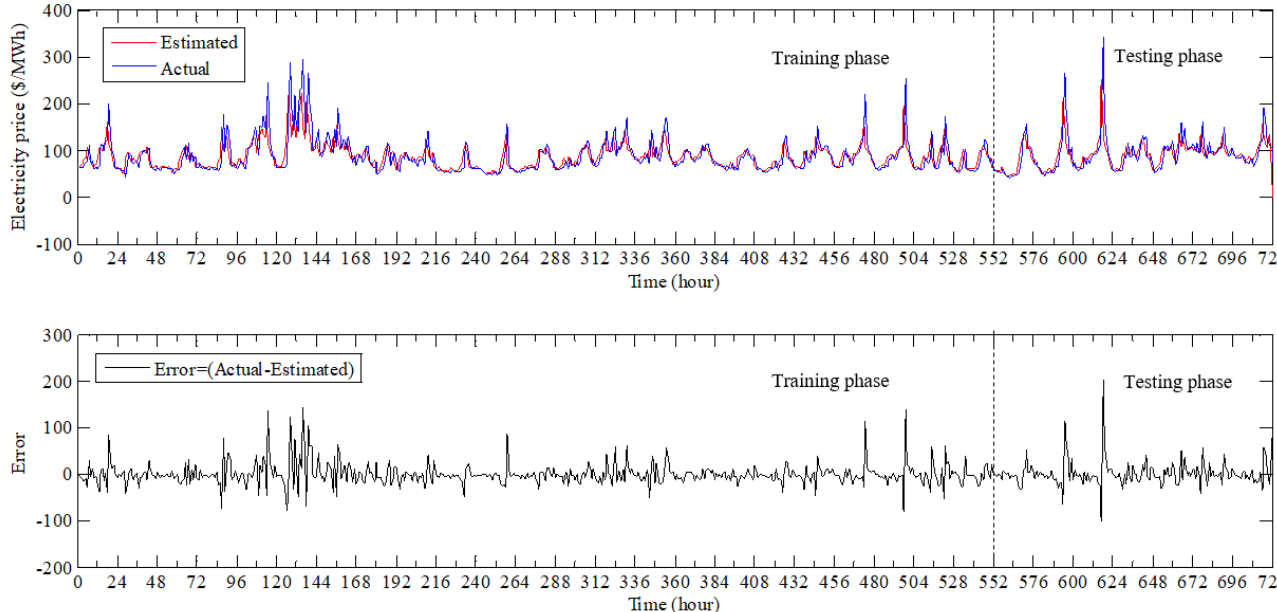
Figure 7. The evaluation of the performance throughout training at the designing and testing phases of ANFIS-BSA and its corresponding error of EPF in August 2018 for QLD.